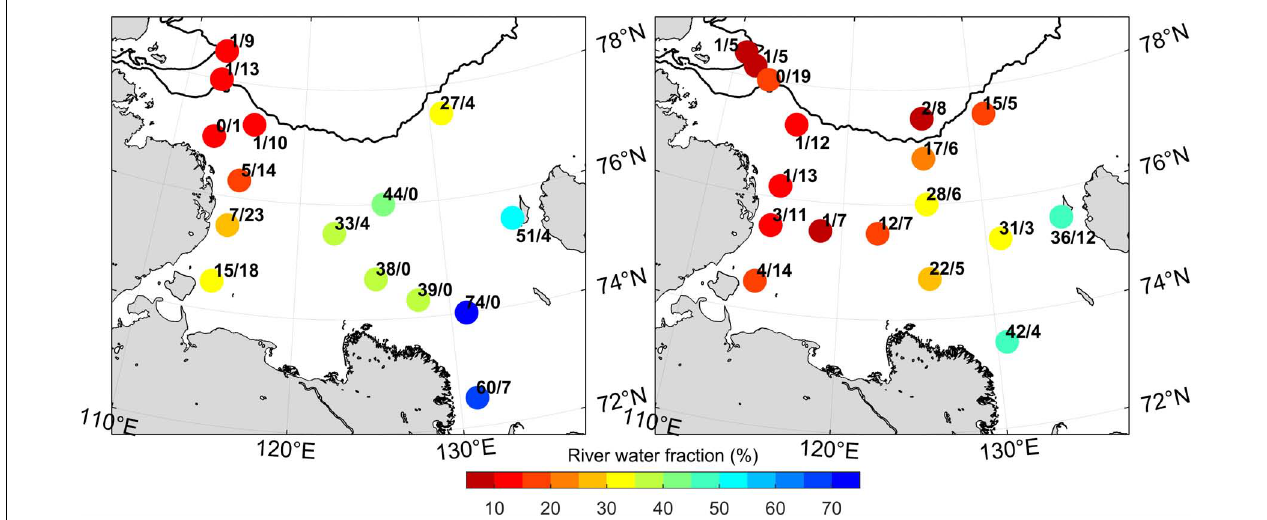
FIGURE 12 | Total river water fraction (in %) (color-coded dots) and contributions (in %) of individual rivers (numbers: first and second number quantify Lena and Ob/Yenisey contributions, respectively) based on a water mass assessment previously reported by Laukert et al. (2017) for the late summers of 2013 (left) and 2014 (right)